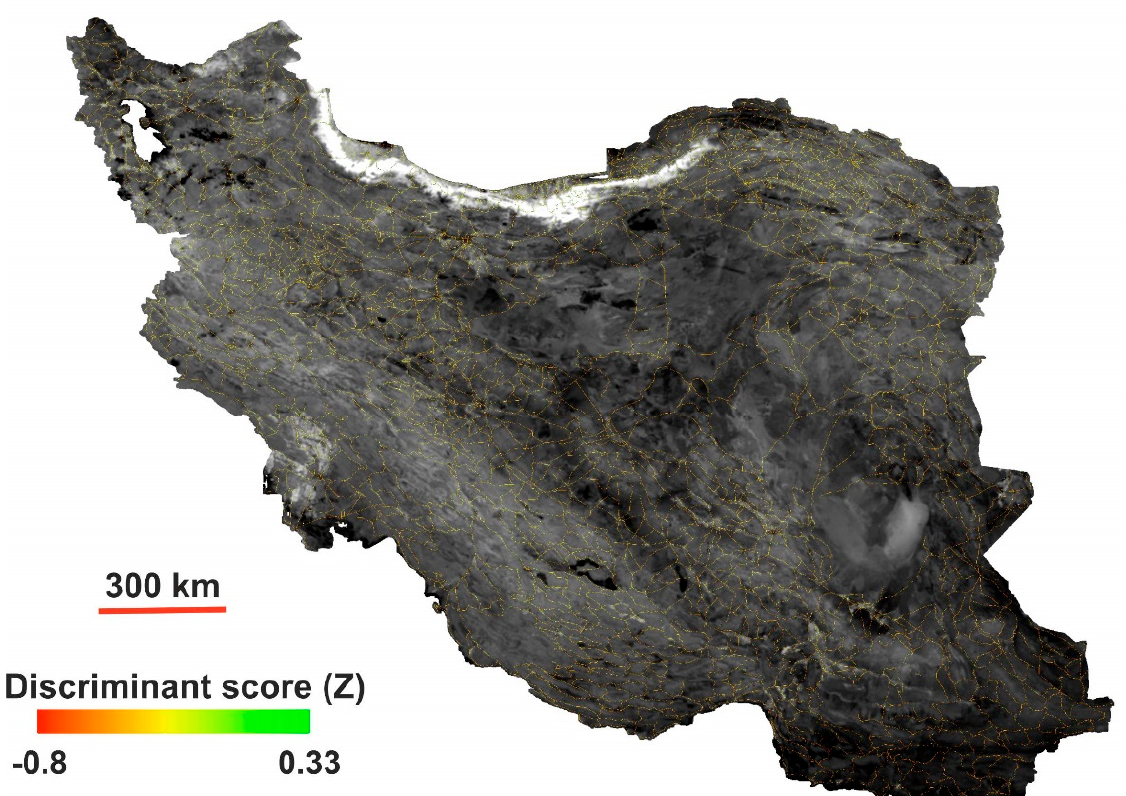
Figure 7. ( a ) Binary road quality proxy map (RQPM) deduced from the OIF and discriminant analysis. ( b ) Binary RQPM deduced from the norm R and discriminant analysis.